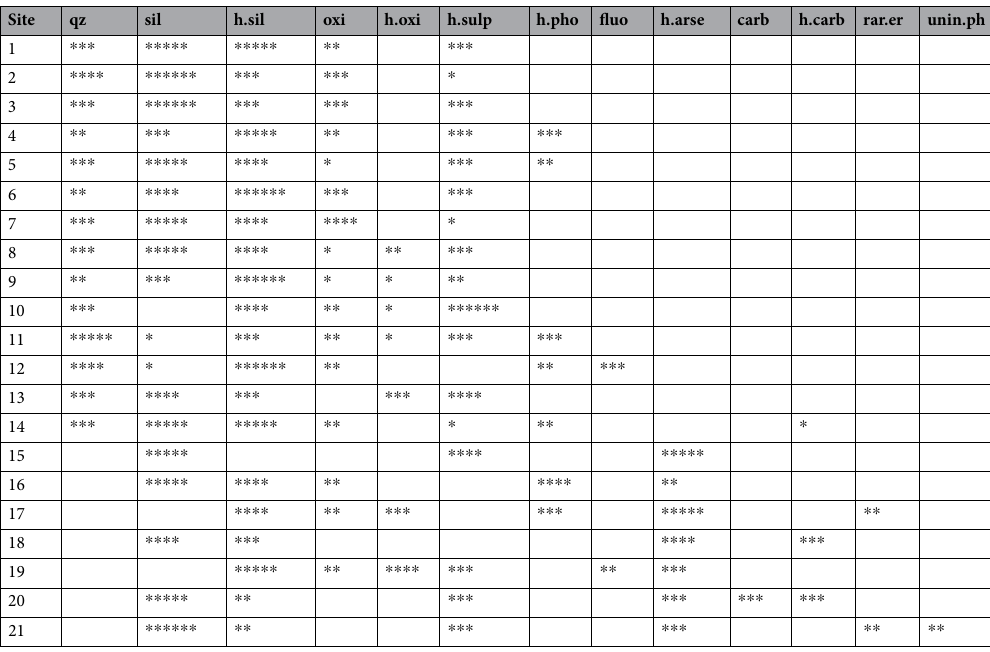
Table 5. Bulk mineralogy of the snow samples. qz: quartz, sil: silicates, h.sil: hydrated silicates, oxi: oxides, h.oxi: hydrated oxides, h.sulp: hydrated sulphates, h.pho: hydrated phosphates, fluo: fluorides, h.arse: hydrated aresenates, carb: carbonates, h.carb: hydrated carbonates, rar.er: rare earth, and unin.ph: unidentified